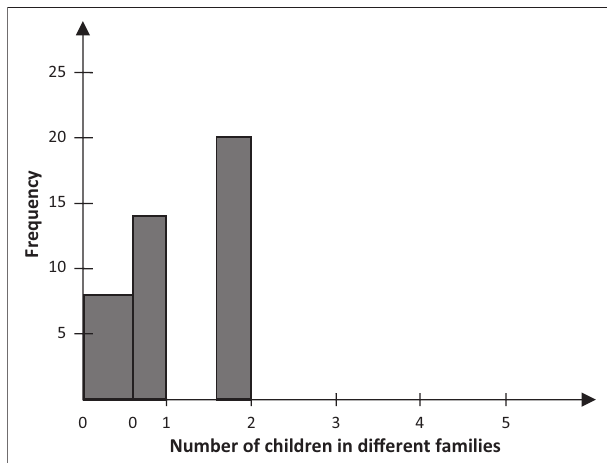
FIGURE 9: Learners’ bar-like graph of survey data.